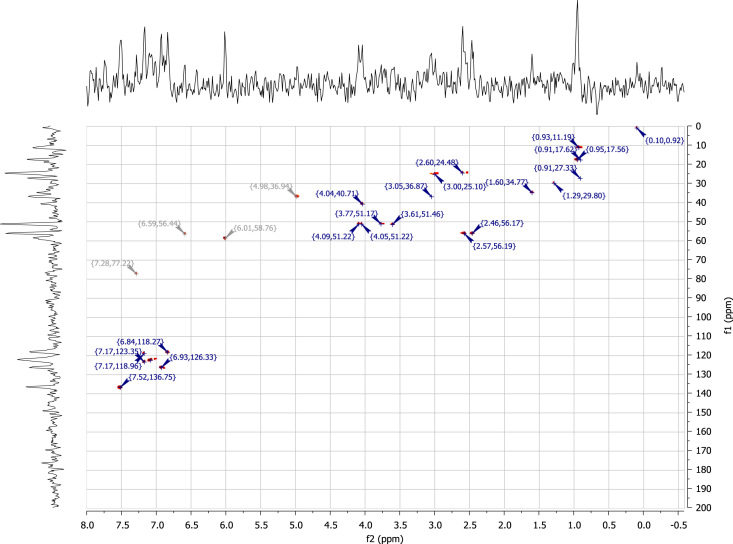
2D HSQC (400 MHz,
CDCl3) of RU-SKI 201
(9d).